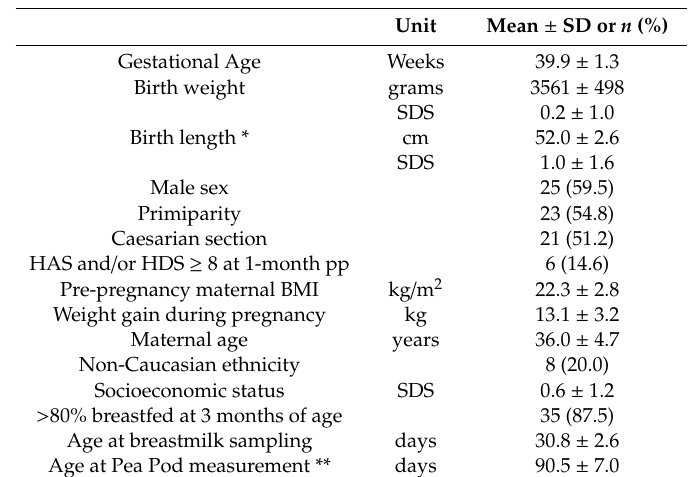
Table 1. Characteristics of the study population ( n =